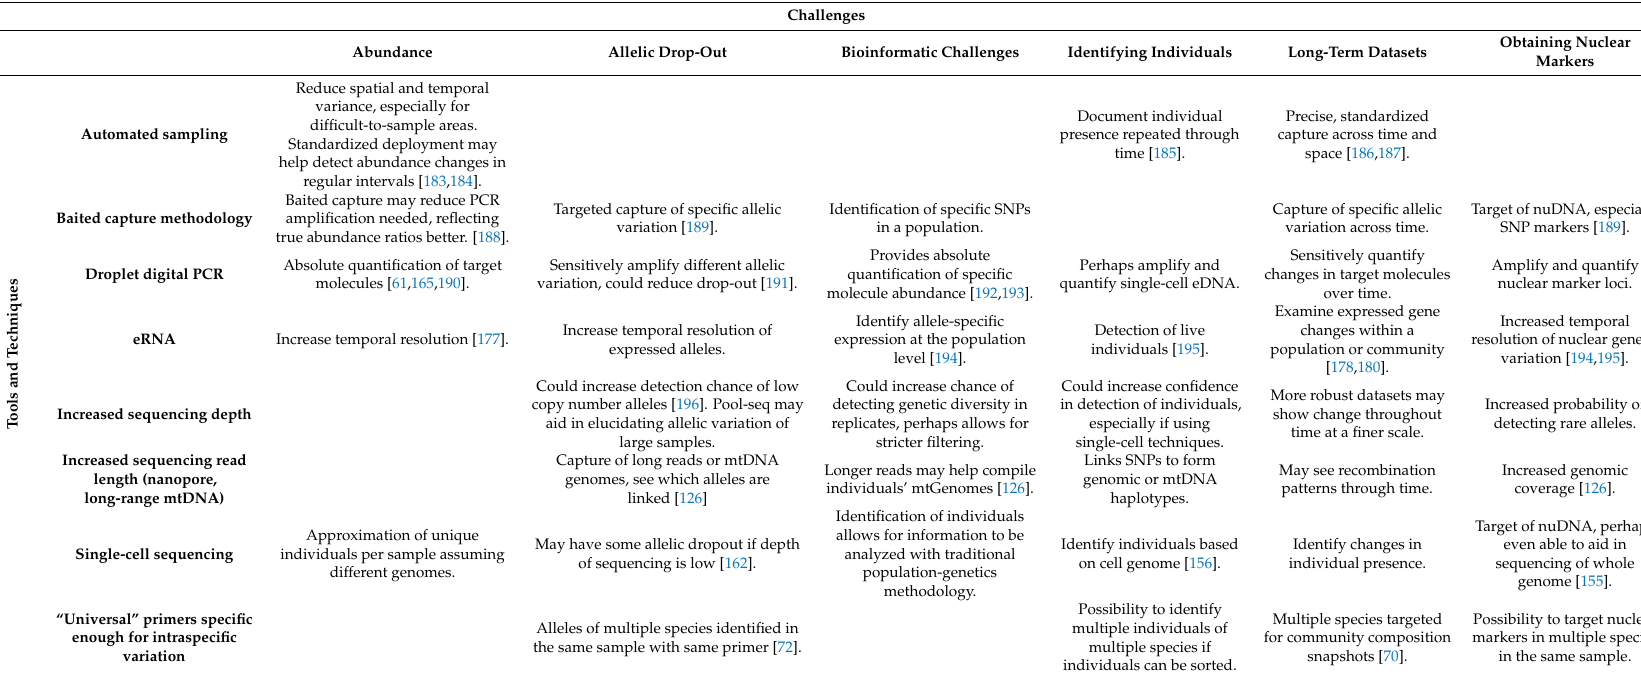
Table 1. Potential challenges facing environmental DNA population genetic research with suggestions for tools to help mitigate some of the challenges. While previous research has applied a number of these tools to these challenges (as cited), research still remains to be done to fully address how each tool can help mitigate each challenge, and to identify advantages and drawbacks of each. Note that not all tools and techniques apply to all